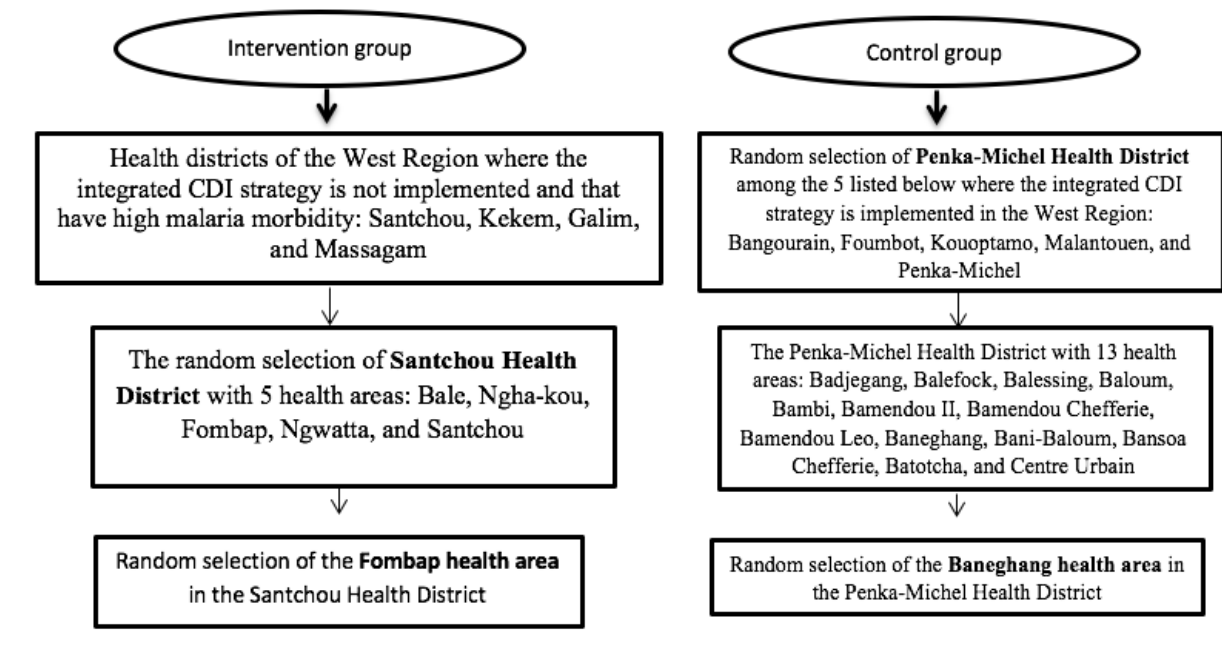
Figure 1. Flow chart of the sampling frame for the selection of 2 groups. CDI: community-directed